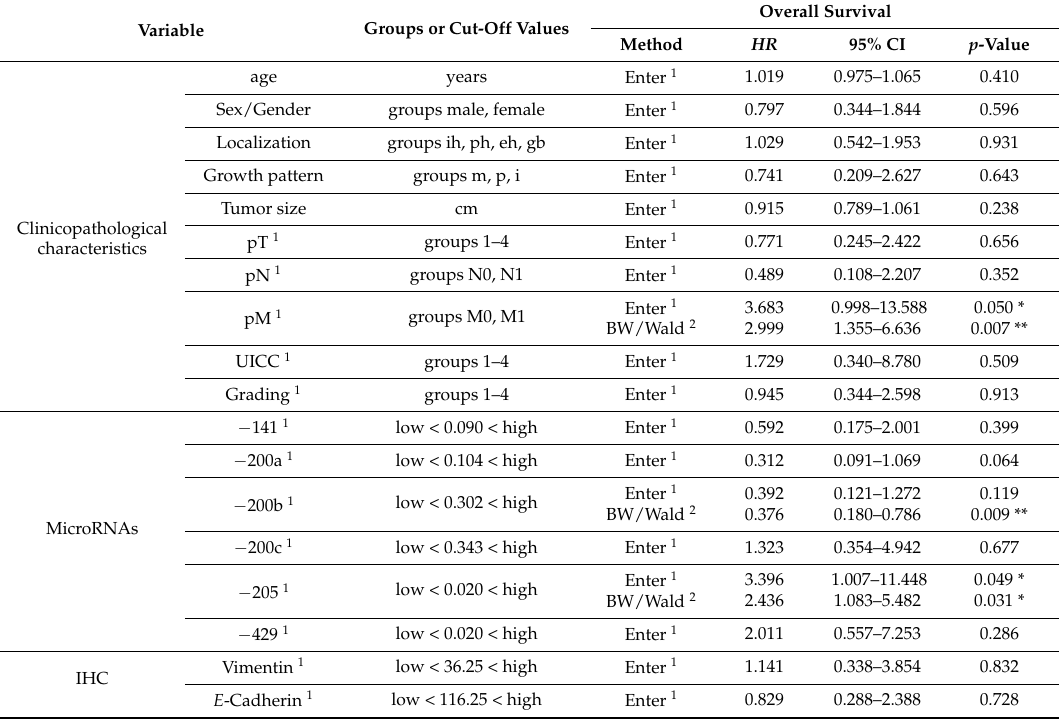
Table 2. Cox regression analysis for overall